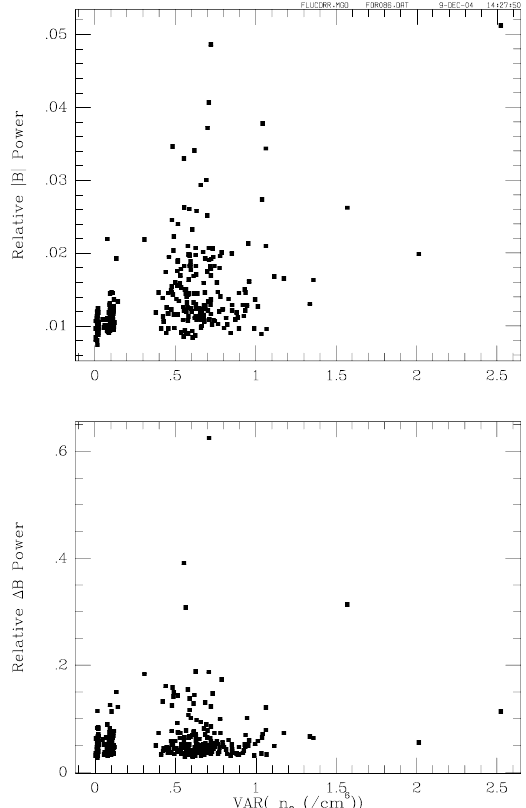
Fig. 8. Scatter plot of the relative power in magnetic and density fluctuations. The lower panel shows the sum of the powers in the three components, the upper shows power in | B |